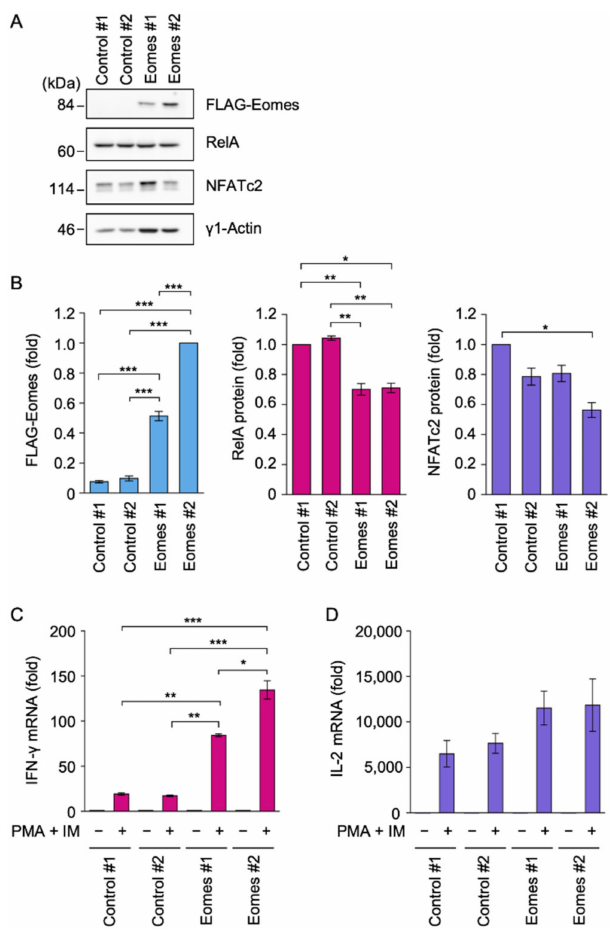
Figure 1. Eomes promoted the expression of IFN- γ mRNA in EL4 cells. ( A , B ) Whole cell lysates were prepared from Control #1, Control #2, Eomes #1, and Eomes #2 EL4 transfectants and used for Western blotting using anti-FLAG, anti-RelA, and anti-NFATc2 antibodies. Blots were representative of five independent experiments ( A ). The amount of FLAG-Eomes, RelA, and NFATc2 was normalized to that of γ 1-actin. The amount of the FLAG-Eomes protein in the Eomes #2 EL4 transfectant was set to 1-fold. The amounts of the RelA protein and NFATc2 protein in the Control #1 EL4 transfectant were set to 1-fold. The FLAG-Eomes protein (fold), RelA protein (fold), and NFATc2 protein (fold) are shown as the mean ± S.E. of five independent experiments. ( C , D ) Control #1, Control #2, Eomes #1, and Eomes #2 EL4 transfectants were treated with (+) or without ( − ) PMA (10 nM) and IM (1 µ M) for 6 h. IFN- γ mRNA ( C ) and IL-2 mRNA ( D ) were measured by quantitative PCR. mRNA levels without PMA and IM in each EL4 transfectant were set to 1-fold. Data are shown as the mean ± S.E. of three independent experiments. * p < 0.05, ** p < 0.01, and *** p < 0.001. A schematic of TCR-induced signaling pathways and the experimental design for EL4 transfectants are shown in Figure S1. EL4 transfectants were incubated with PMA and IM for 6 h. The PMA and IM stimulation induced approximately 20-fold increases in IFN- γ mRNA expression in Control #1 and Control #2 transfectants (Figure 1C). In comparison with control transfectants, the PMA and IM stimulation induced approximately 80- and 130-fold increases in IFN- γ mRNA expression in Eomes #1 and Eomes #2